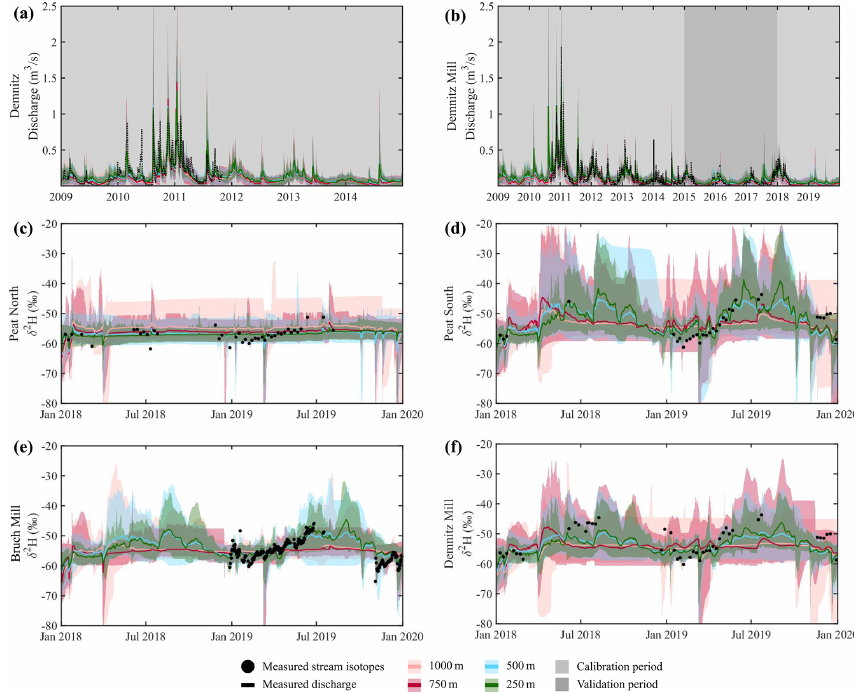
Figure 3. Simulated discharge at (a) Demnitz and (b) Demnitz Mill and stream isotopes at (c) Peat North, (d) Peat South, (e) Bruch Mill, and (f) Demnitz Mill. Colours indicate the model resolution, with the solid lines showing the median simulation and the shaded regions showing the upper and lower simulation